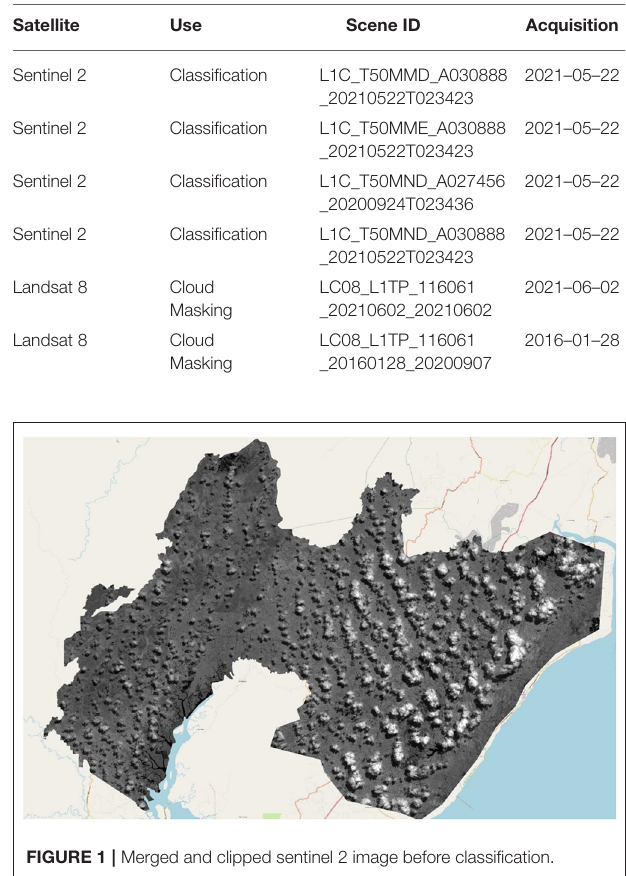
TABLE 1 | Remote sensing data used for selecting the IKN area.